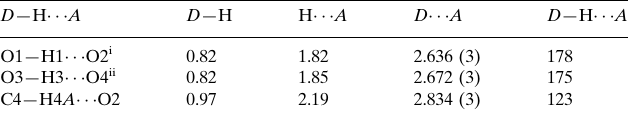
Hydrogen-bond geometry (A˚ , (cid:2)